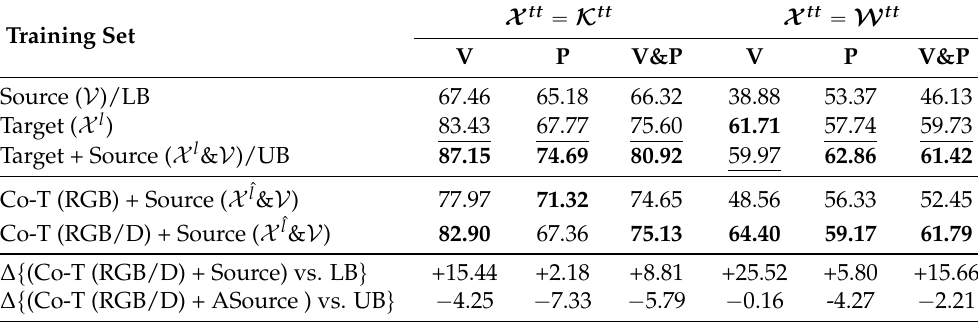
Table 5. SSL (co-training) results on vehicle (V) and pedestrian (P) detection, under domain shift, reported as mAP. X l refers to the human-labeled target-domain training set; thus, if X tt “ K tt ,